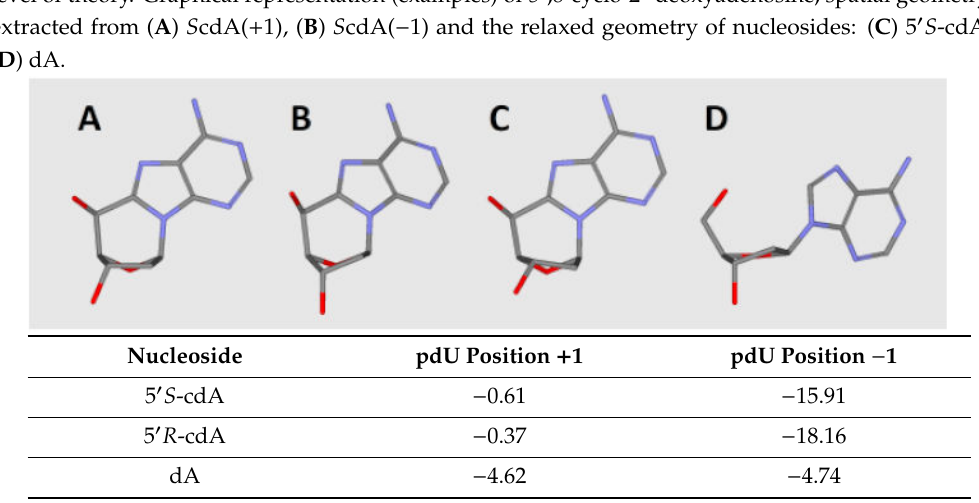
Energy di ff erence in kcal between relaxed nucleosides extracted from ds- DNA: 2 (cid:48) -deoxyadenosine, (5 (cid:48) R ) and (5 (cid:48) S )-5 (cid:48) ,8-cyclo-2 (cid:48) -deoxyadenosine, calculated at the B3LYP / 6-31G ** level of theory. Graphical representation (examples) of 5 (cid:48) ,8-cyclo-2 (cid:48) -deoxyadenosine, spatial